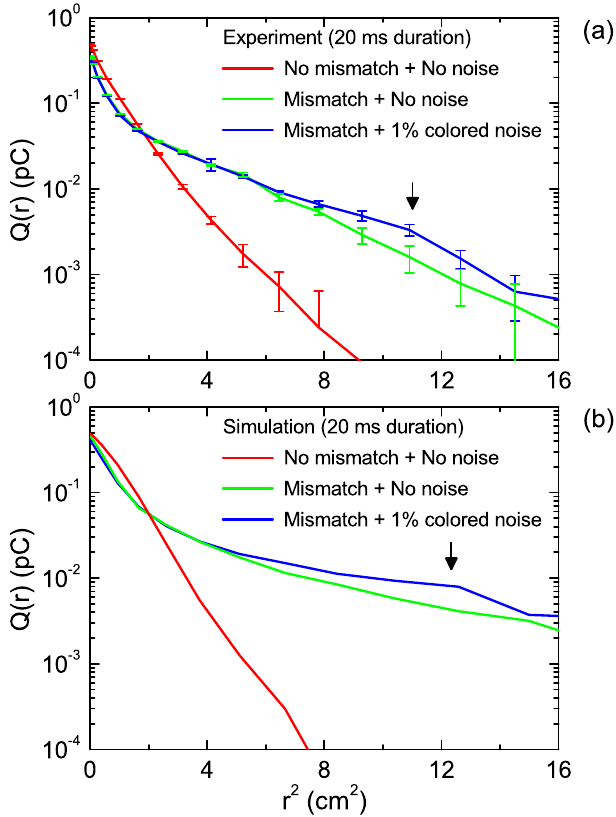
FIG. 10. (Color) Radial profiles are either (a) measured from the experiments, or (b) obtained from the PIC simulations. Three different external perturbation scenarios are considered: no perturbation (red curves); instantaneous mismatch only (green curves); and both instantaneous mismatch and colored noise with ¼ 5 T and (cid:1) ¼ 1% (blue (cid:5) ac max